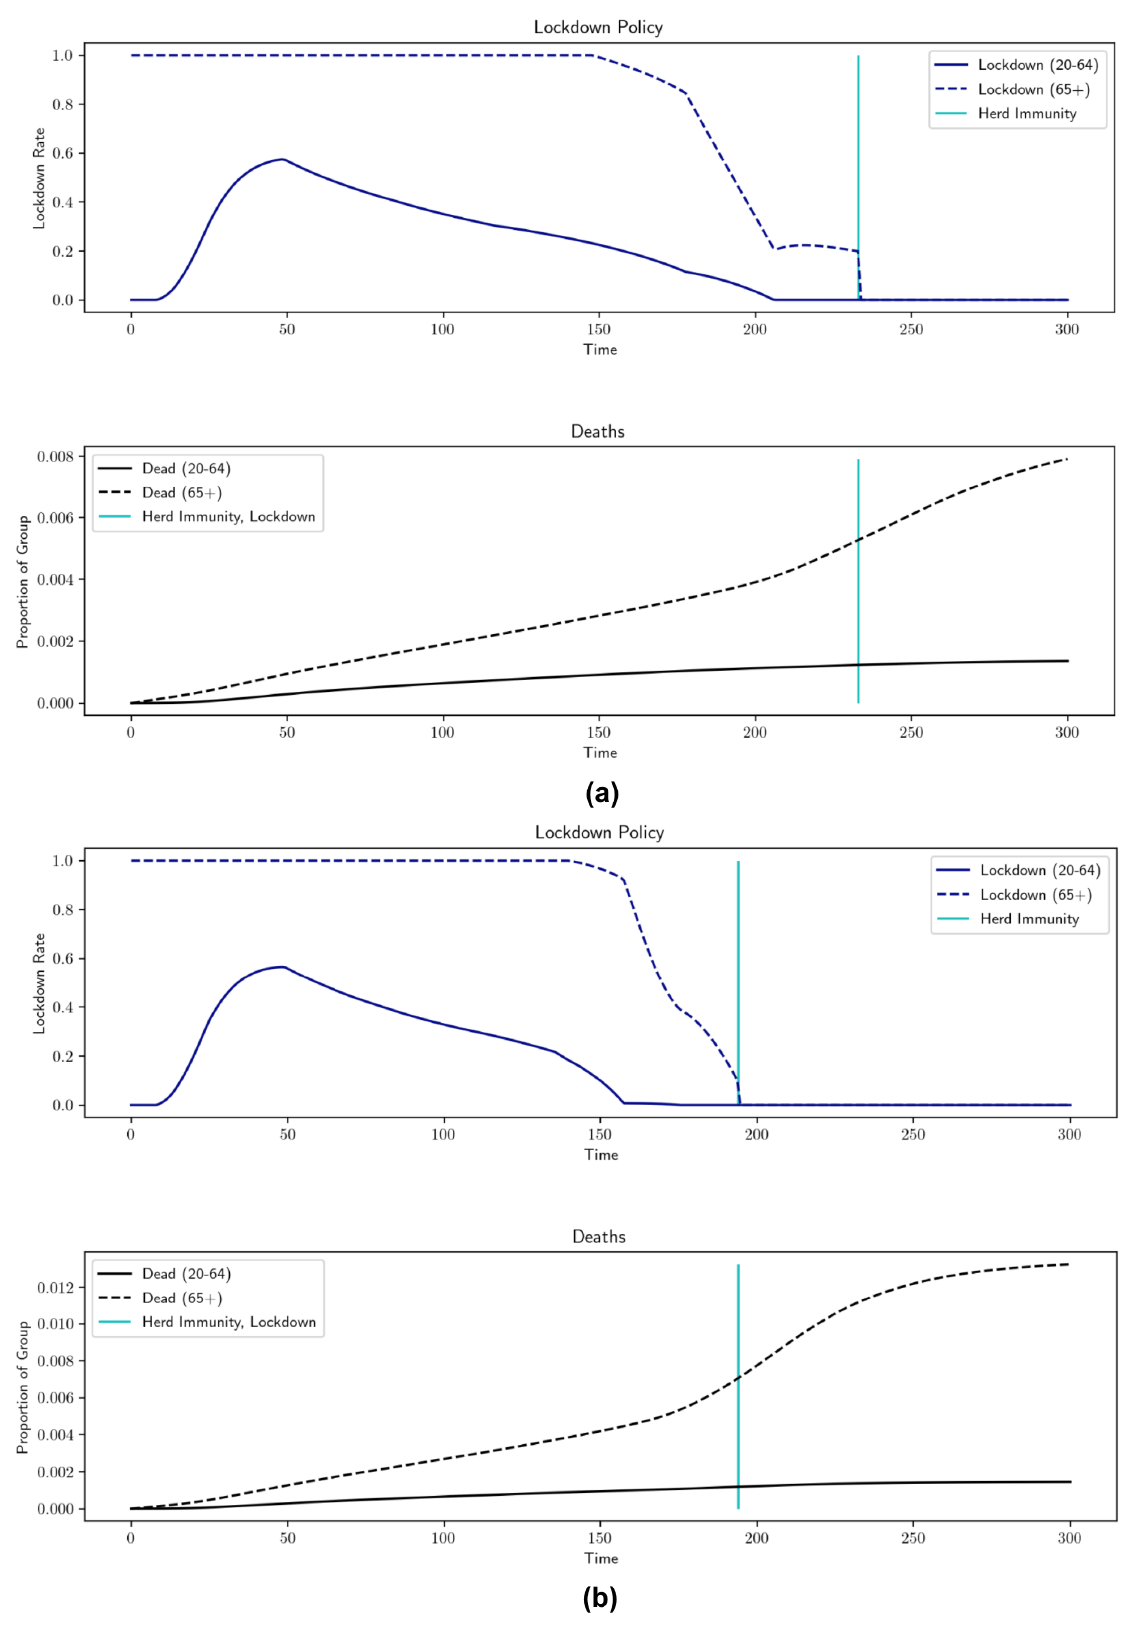
Figure 9. Robustness results for ρ (inter-group interaction level). χ = 10/ r , r = 0.001%, ν = 0.67, α L = 10 − 5 , α I = 1, α E = 0.42, η = 10, F = 1, h = 0.4, ( a ) ρ = 0.5, lockdown: 233 d, output loss = 8.118%, total deaths = 0.2753%; ( b ) ρ = 1, lockdown: 194 d, output loss = 7.0292%, total deaths =